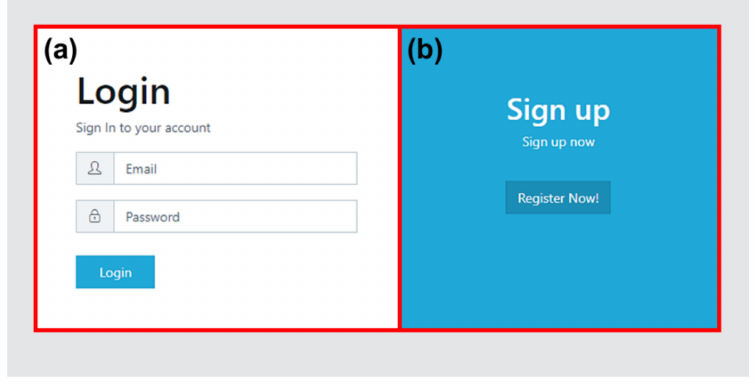
Figure A3. The user interface of the login and sign up page: ( a ) login panel and ( b ) sign-up panel.